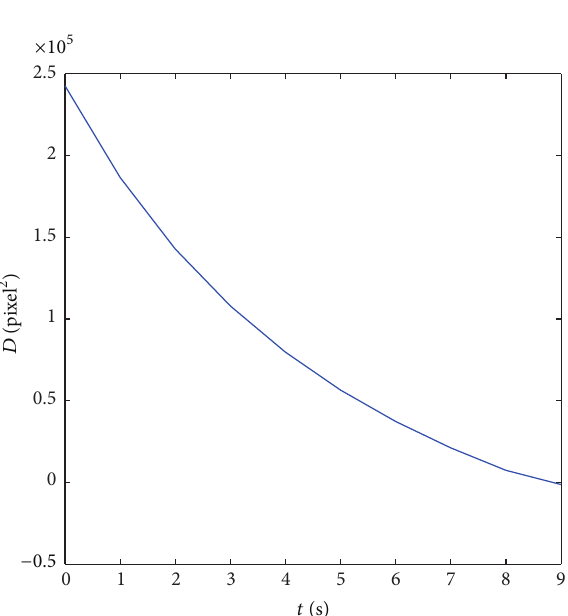
Figure 18: Experimental results. Exponential decrease of the differ- ence 𝐷 between the actual and desired